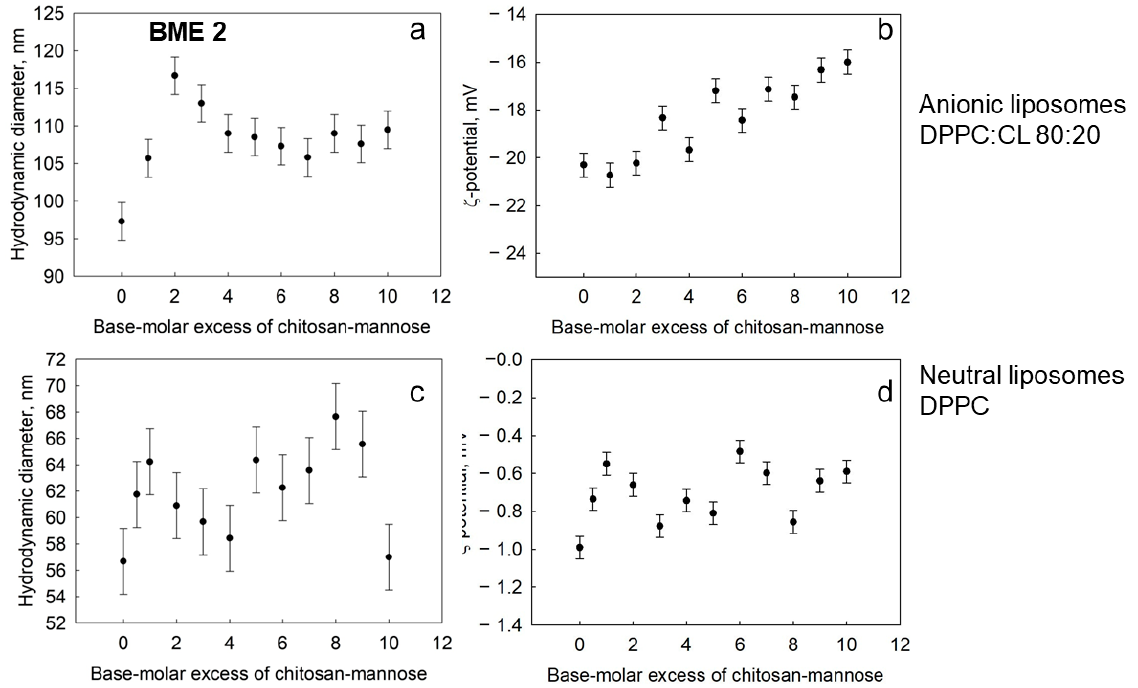
Figure 5. Dependance of main physicochemical properties of liposomal complex with ChitMan with preheating at 37 ° С for 45 min: DPPC: CL 80:20 liposomes (Dh, nm ( a ) and ζ -potential, mV ( b )) and DPPC liposomes (Dh, nm ( c ) and ζ -potential, mV ( d )). SD, n = 3. 0.02 M Na-phosphate buffer solution, pH 7.4, 22 ° С .